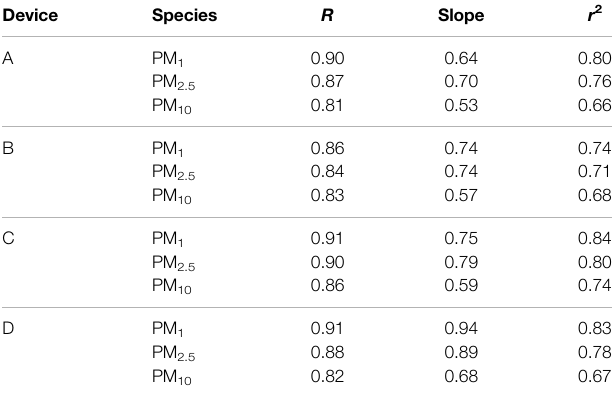
TABLE 4 | Correlation results for Altasense PM vs . FIDAS for the period 23.04.21 – 27.04.21 after correction using the multi-linear approach. One device (B) has a tendency to underestimate compared to the other sensors. This device has performed slightly worse than the others in linearity correlations, and this demonstrates some of the concerns about the replicability of data between low-cost sensors due to the unknown manufacturing standards. Despite this, it still generally performs well.